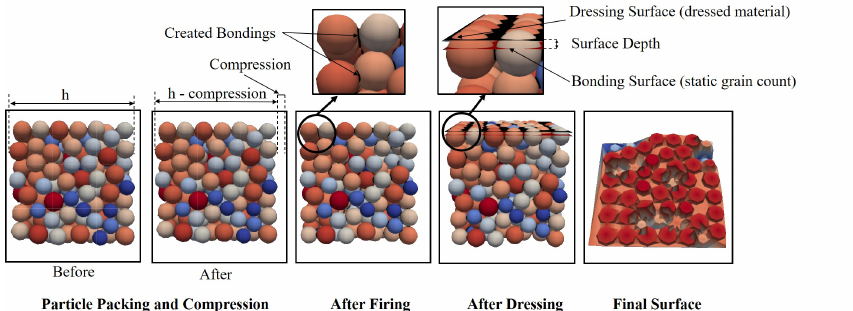
Figure 15. Visualisation of the simulation